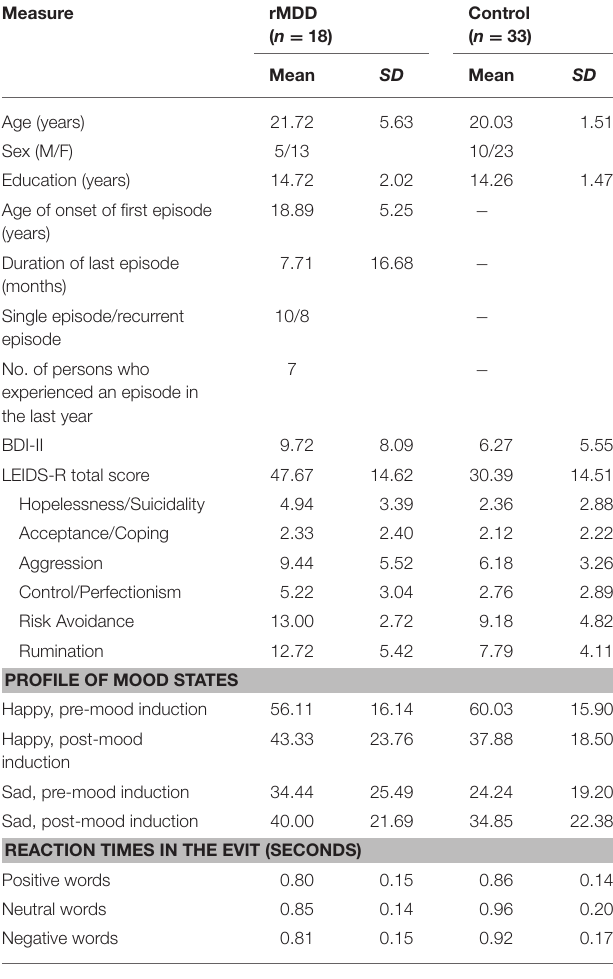
TABLE 1 | Demographic and clinical characteristics and behavioral